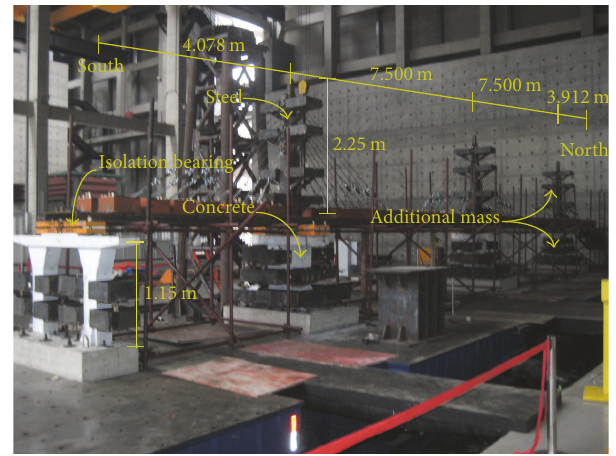
Figure 1: Designed shaking table test model of three-pylon cable-stayed